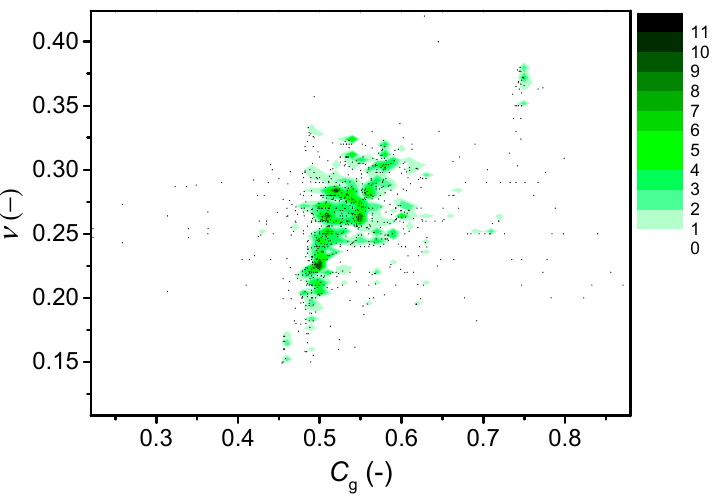
Figure 2. Dependence of Poisson’s ratio ( ν ) on atomic packing density ( C g ) for various glass systems, including those from Table 1. The scale represents the multiplicity of data points. References for literature data are given in the text. C g is calculated according to Equation (3), building on the structural assumptions described in the Supporting Information. The errors associated with ν and C g are 0.01 and 0.002, respectively. R 2 value for a sigmoidal fit to the data is 0.162.